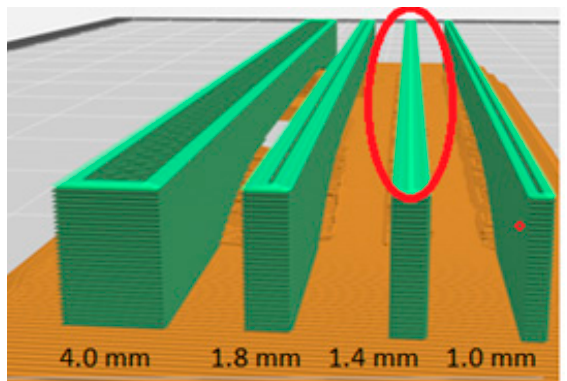
Figure 15. S imulation of 3D printing of specimens in the Y orientation. Figure 15. Simulation of 3D printing of specimens in the Y